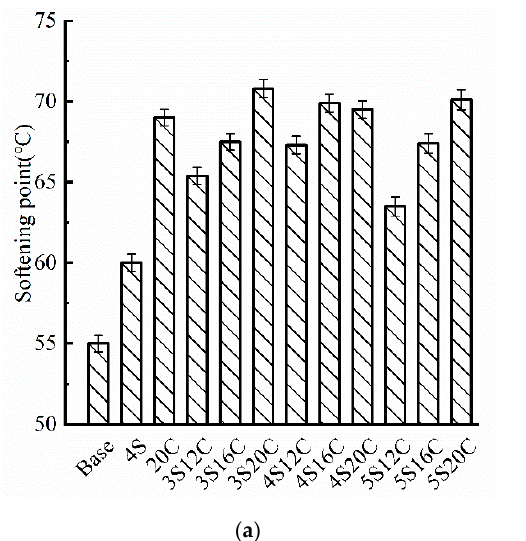
Figure 3. Brookfield viscosity of different experimental groups (180 °C, cP).